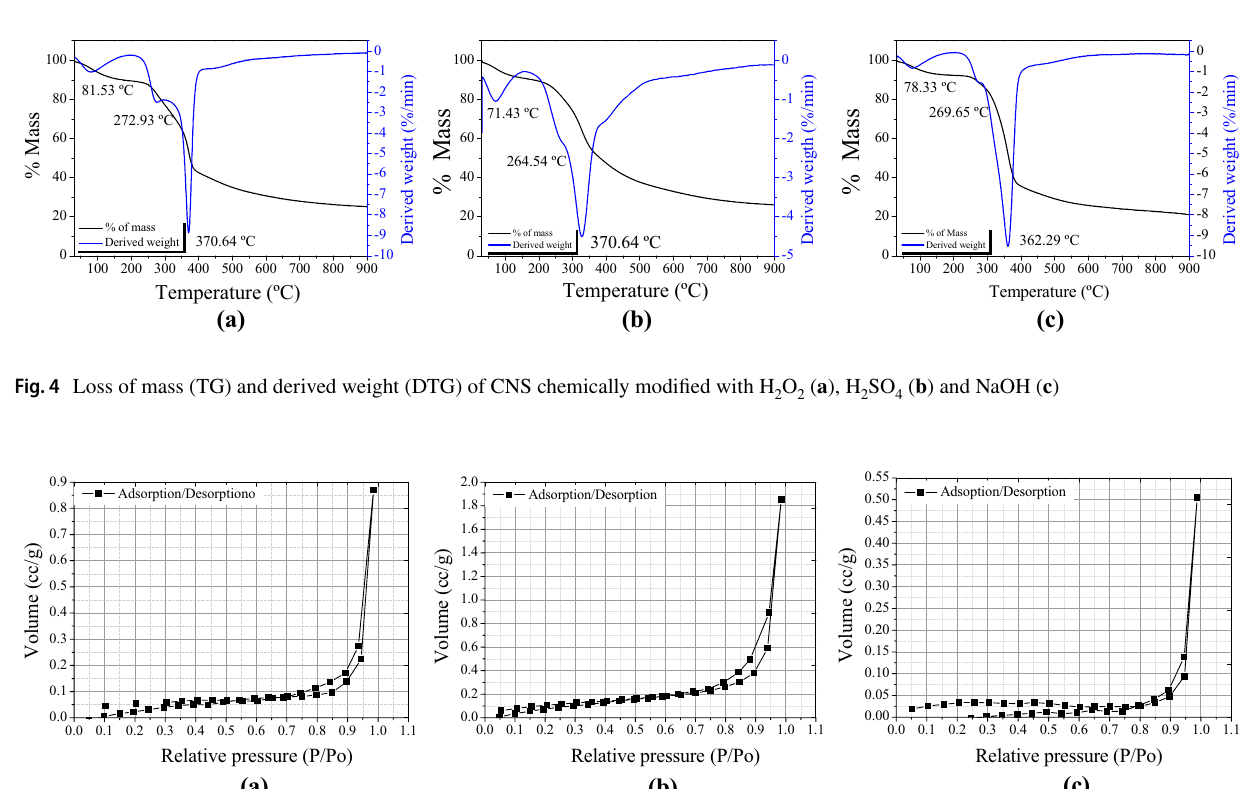
0.0 0.1 0.2 0.3 0.4 0.5 0.6 0.7 0.8 0.9 1.0 1.1